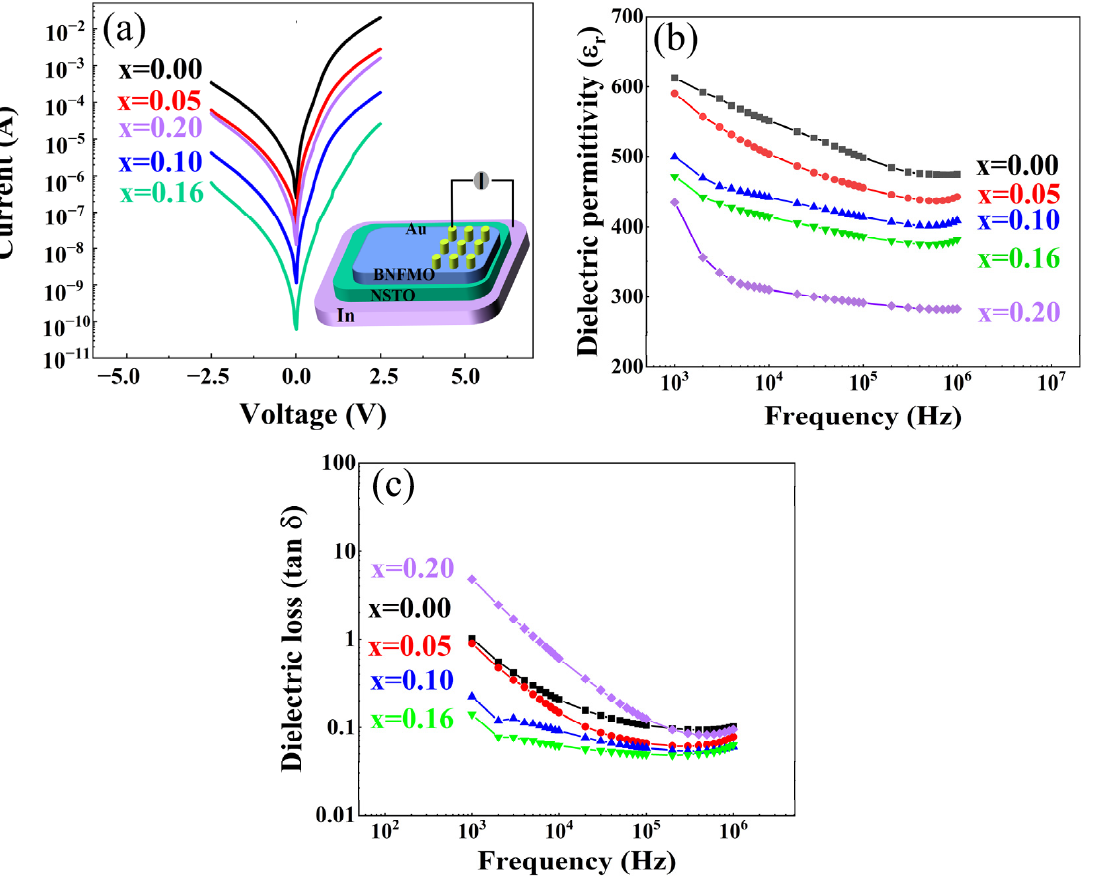
Figure 4. ( a ) Voltage dependence of leakage current of BNFMO films. The inset shows the schematic drawing of the device structure. ( b ) Dielectric permittivity ( Ɛ r ). ( c ) Dielectric loss (tan δ ) of BNFMO films recorded at room temperature.